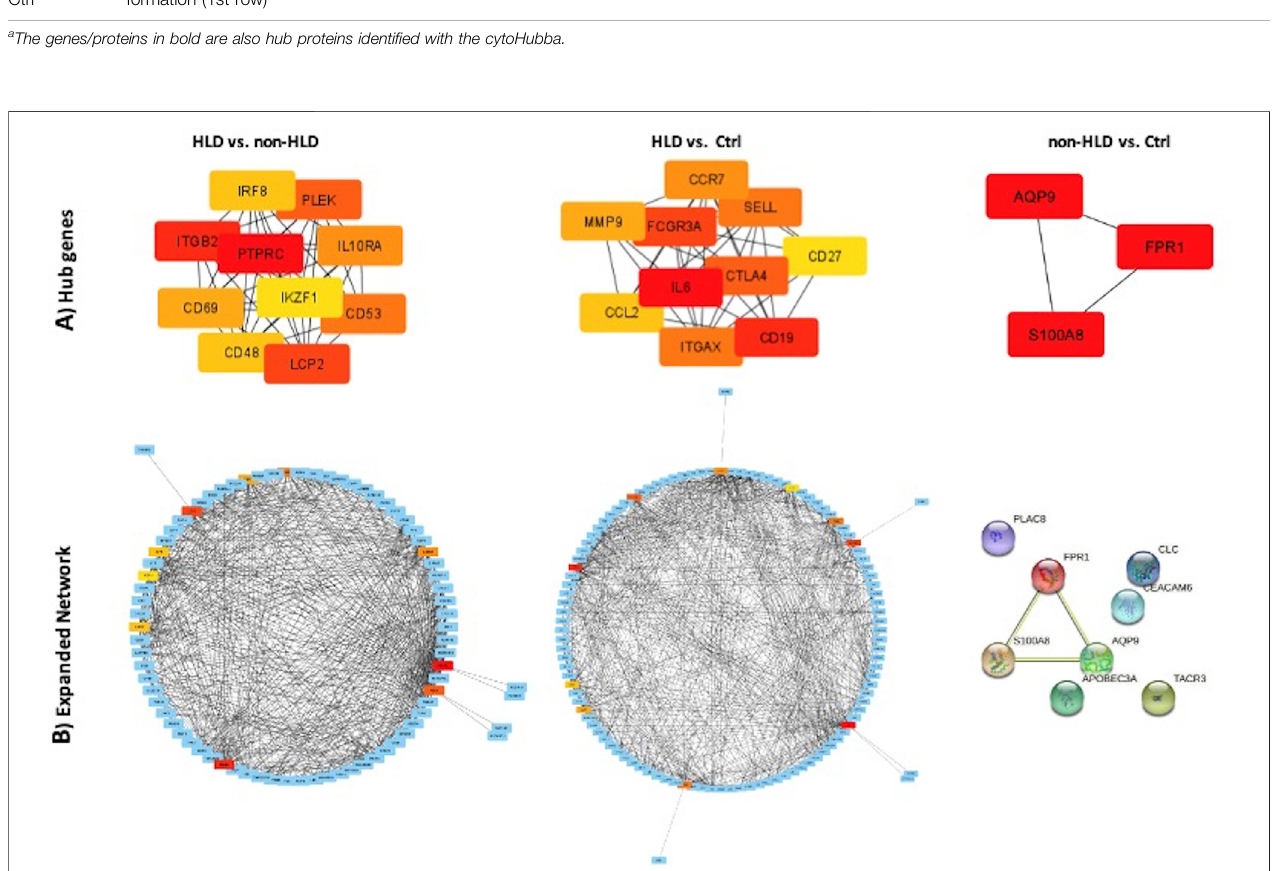
Frontiers in Pharmacology |